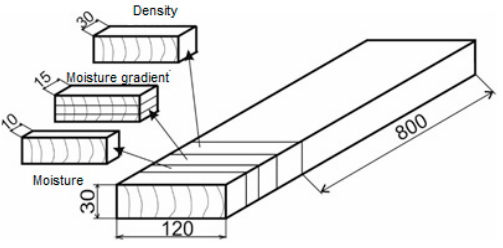
Figure 4. Method of selecting the samples.